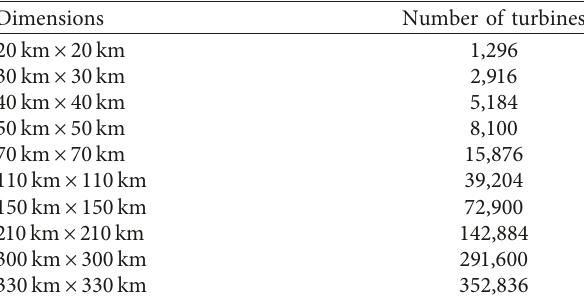
Figure 14: Cyclone tracks for the control (black) and wind farm location ensemble members (color) for the 3 October 2013 tropical cyclone (a) and 26 April 2014 midlatitude cyclone (b). Wind farm locations are outlined in gray. Table 2: Wind farm size ensemble member